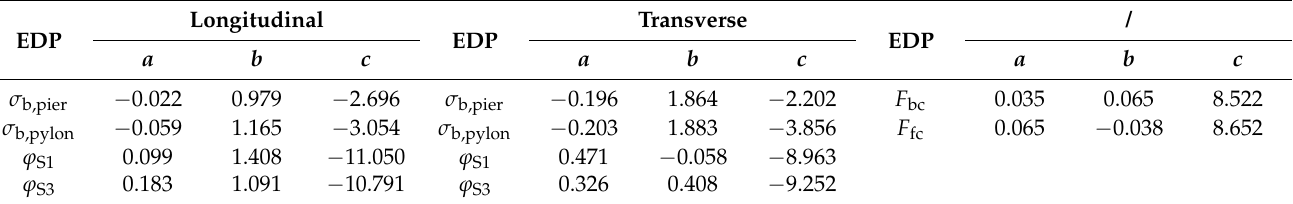
Table 7. Regression coefficients for the PSDMs.